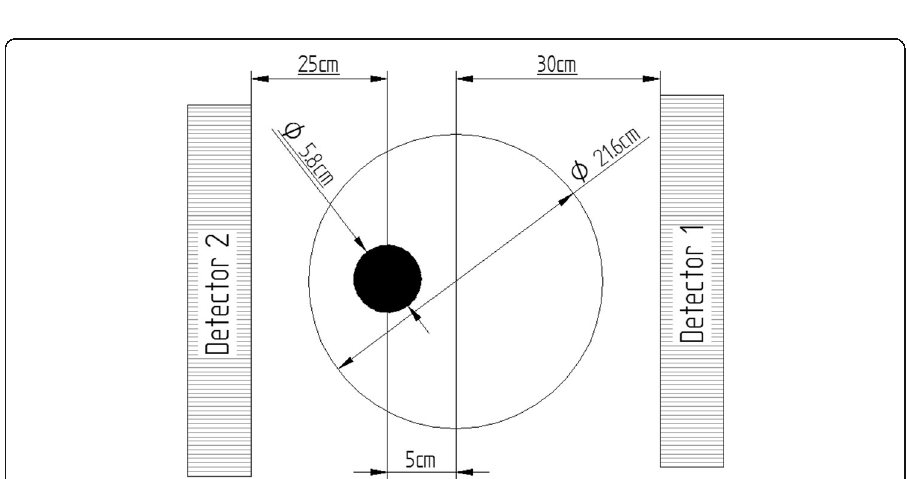
Fig. 1 Coronal view of the positioning of the phantom and the bottle inside it with respect to the two